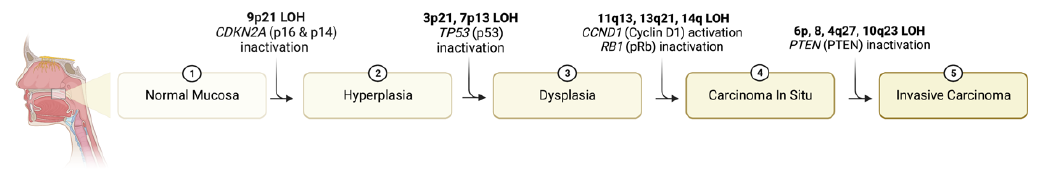
Figure 2. Genetic progression model of head and neck squamous cell carcinoma. Accumulation of loss of heterozygosity or amplification at various genetic loci occurs as lesions proceed from normal mucosa to hyperplasia to dysplasia to carcinoma in situ to invasive carcinoma. Created with Bio- Render.